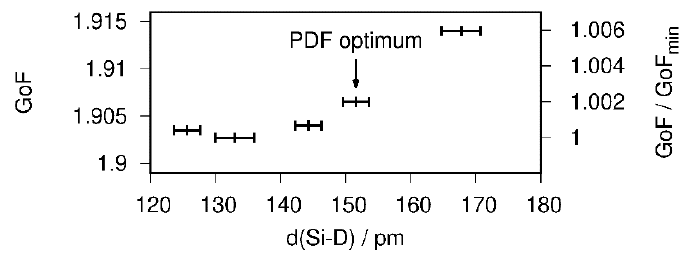
Figure 5. Influence of the Si–D bond length on the goodness of fit (GoF) of the Rietveld refinement of the crystal structure of CaSiD 1.1 (space group Pnma ) based on neutron diffraction data.